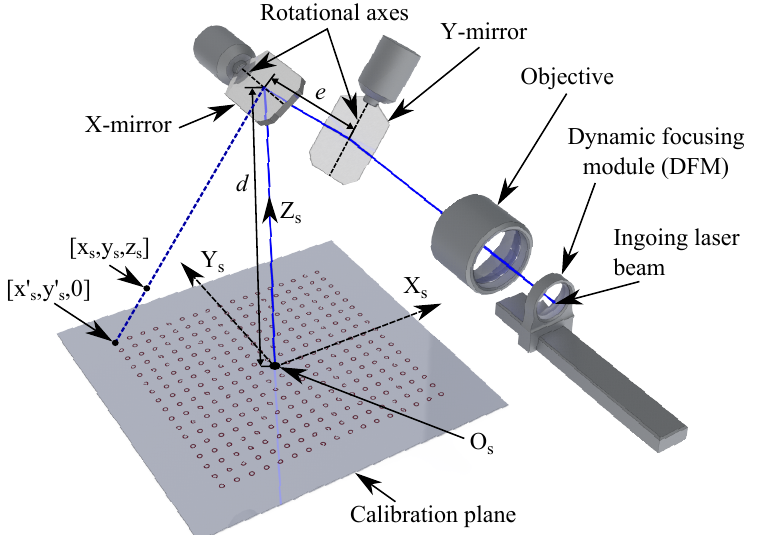
Figure 2. The optical chain of a pre-objective dual galvanometric system on which the geometrical model is based. The blue line indicates the path of the laser